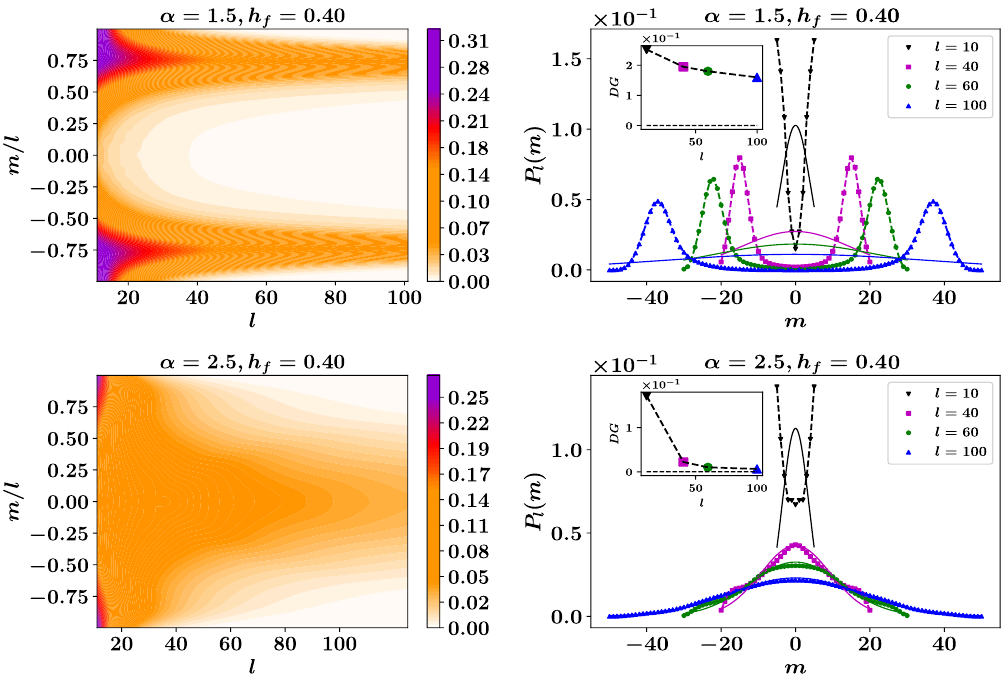
Figure 2: Contour plot of the late time PDF of subsystem magnetization after a quantum quench as a function of subsystem size, for α ∈ { 1.5,2.5 } , h and time t = 25. The subsystem magnetization m has been rescaled to the range m / l ∈ [ − 1.0,1.0 ] , due to this rescaling the intensity of the contour plot decreases with increasing l and the colorbar readings doesn’t signify the actual value of PDF. The second column shows PDF at four representative values of l . The symbols are TDVP results and the full lines are the Gaussian approximation 10. The inset shows the dependence of DG on l